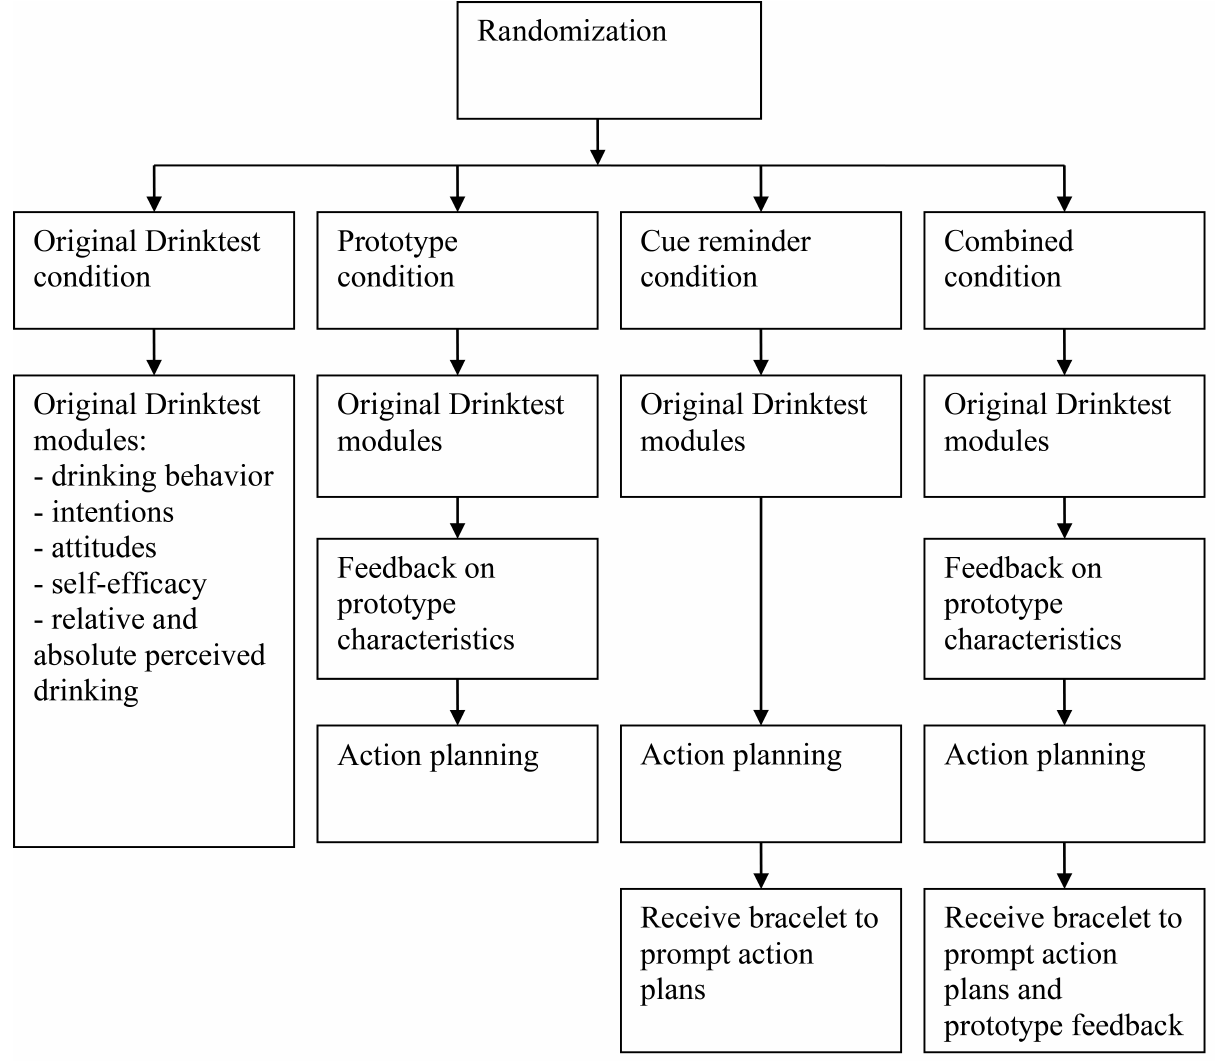
Figure 1. Flowchart illustrating the flow of the intervention per